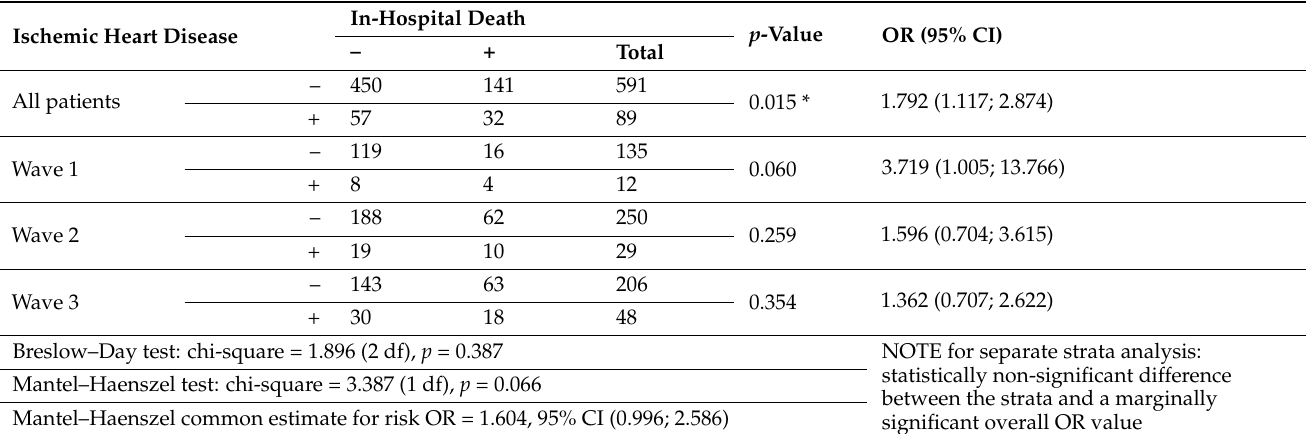
Table 5. Association of ischemic heart disease (IHD) with in-hospital mortality on the three-wave